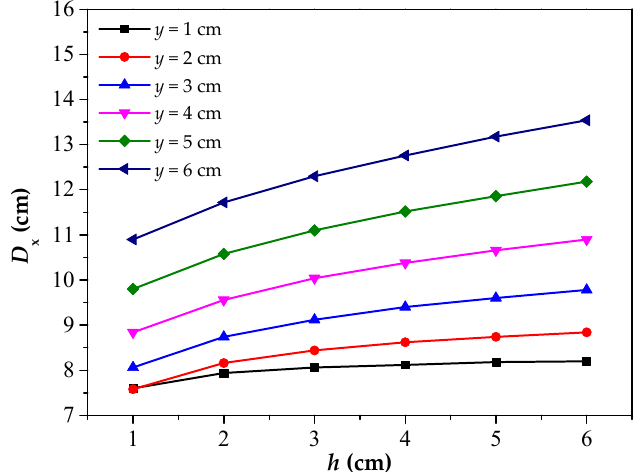
Figure 10. The relationship between D x and h under di ff erent y . D x : the intersecting point distance between curves of magnetic flux component of x direction at di ff erent lift o ff heights; h : the depth of corrosion defect; Y : the lift o ff height.